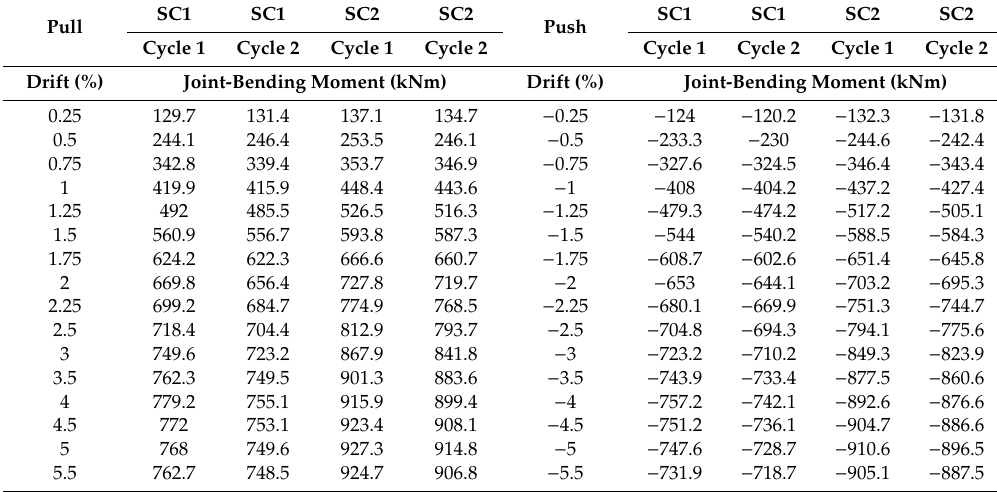
Table 2. Summary of the test results.